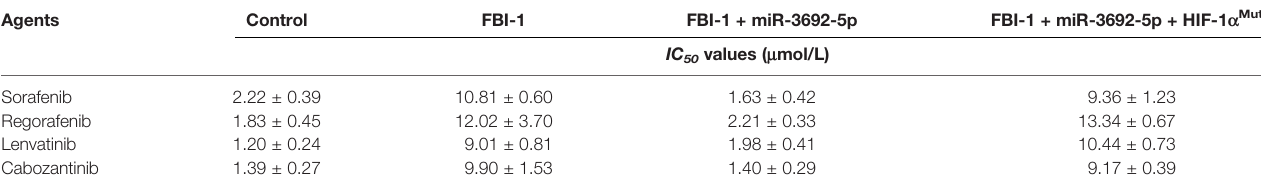
TABLE 3 | FBI-1 induces the resistance of MHCC97-L cells to molecular targeted agents. Agents Control FBI-1 FBI-1 + miR-3692-5p FBI-1 + miR-3692-5p + HIF-1 a Mut